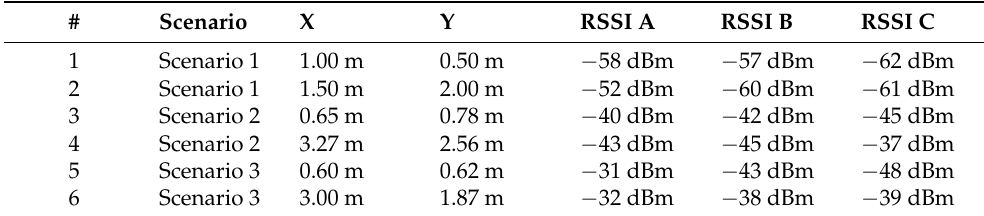
Table 1. Sample records from the RSSI data set.